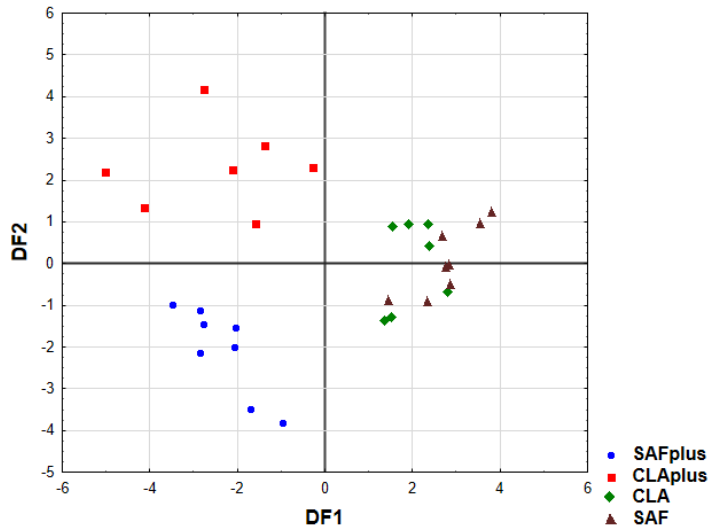
Figure 4. Scatter plot of canonical values for functions DF1 and DF2. SAF group—animals receiving safflower oil; SAFplus group—animals receiving safflower oil treated with DMBA; CLA group—group of animals receiving Bio-C.L.A.; CLAplus group—group of animals receiving Bio-C.L.A. treated with DMBA